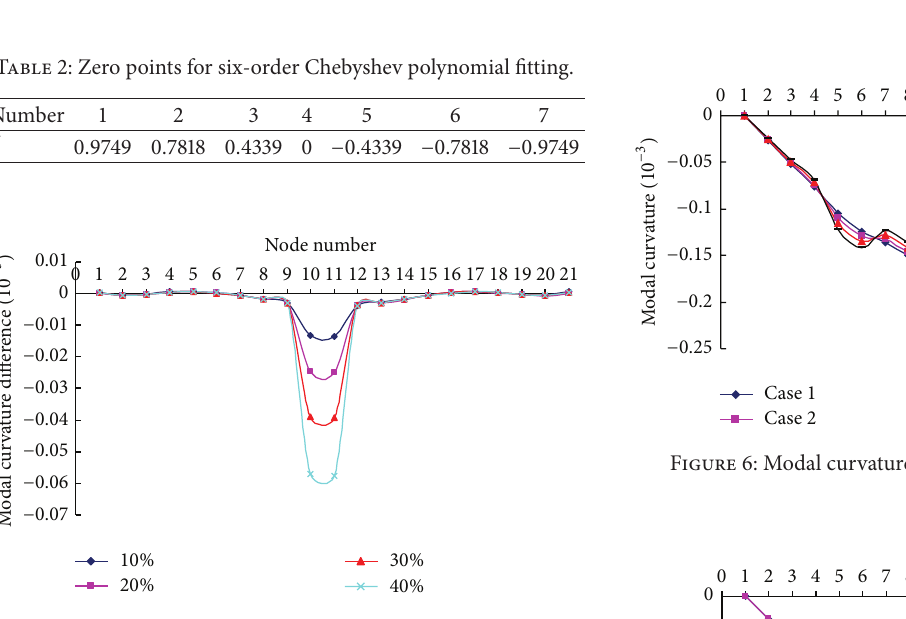
Figure 5: Modal curvature difference of element 10 with damage severity (10%, 20%, 30%, and 40%).